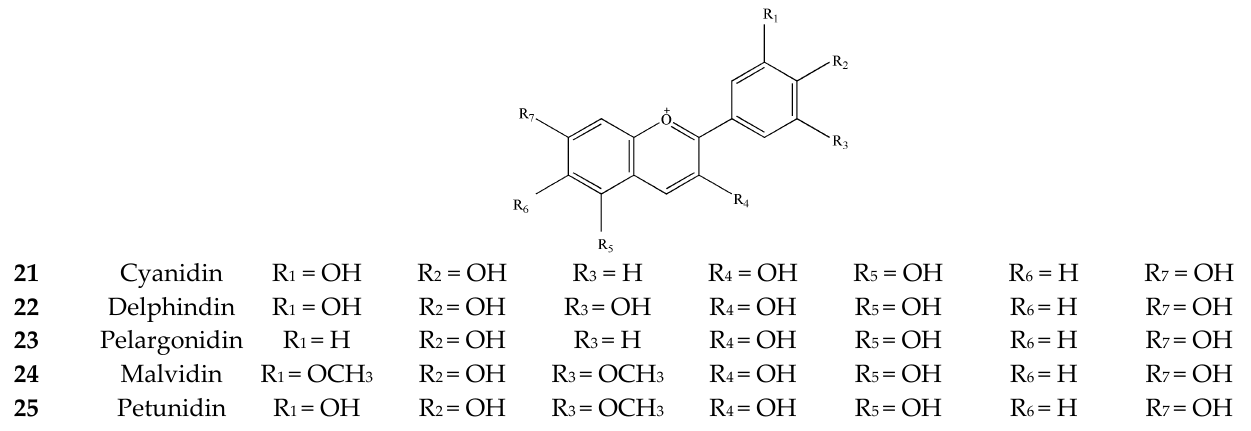
Figure 3. Chemical structures of anthocyanins isolated from green tea.